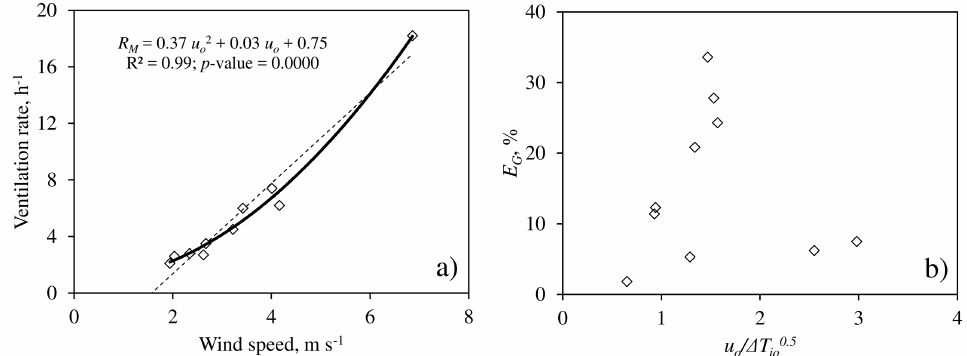
Figure 5. Ventilation rate for greenhouse as a function of air velocity ( a ). Error of closure of the flows E G in function of the ratio u o / ∆ T io0.5 ( b ). Subfigure ( a ): second order polynomial fit ( ─ ); linear fit (---). Table 4. Average values G (Equation (8)) and turbulent component G’ (Equation (9)) of the ventilation volumetric flow rates through each vent opening. Error in the calculation of ventilation volumetric flow rates E G and average values of ventilation rate R . LS , leeward side vent; WS , windward side vent; WR , windward roof vent; M , average values for the greenhouse.